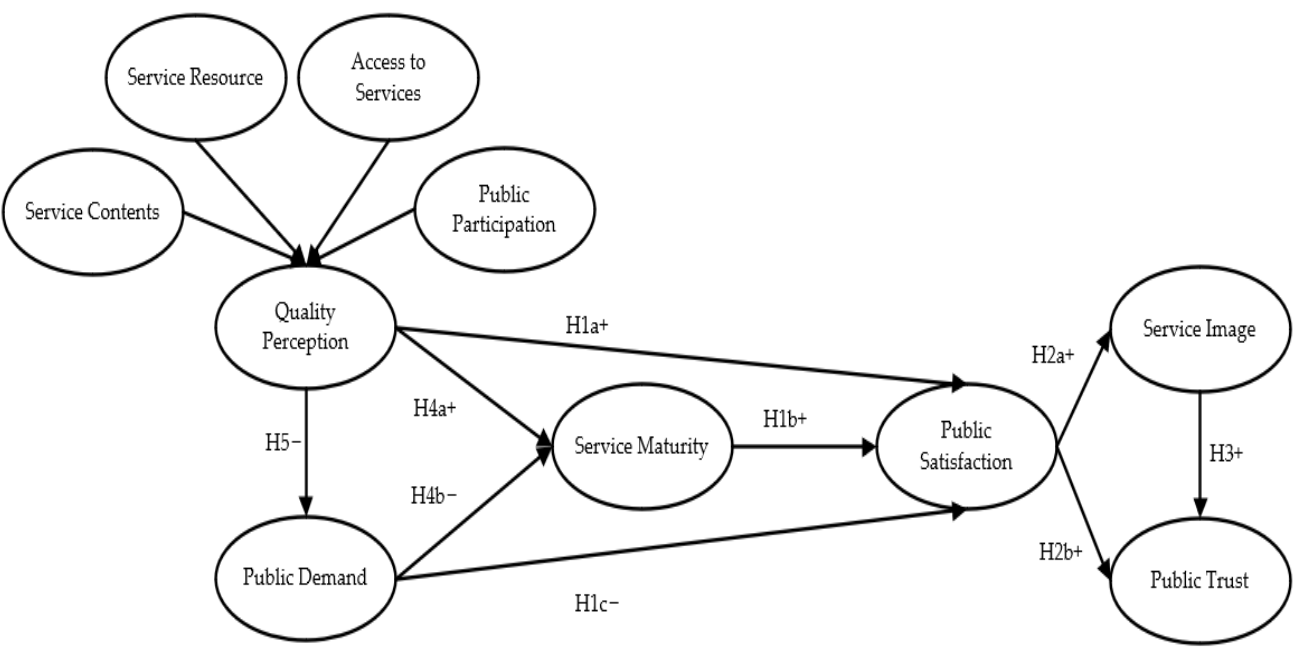
Figure 2. The public satisfaction model of community services for COVID-19.